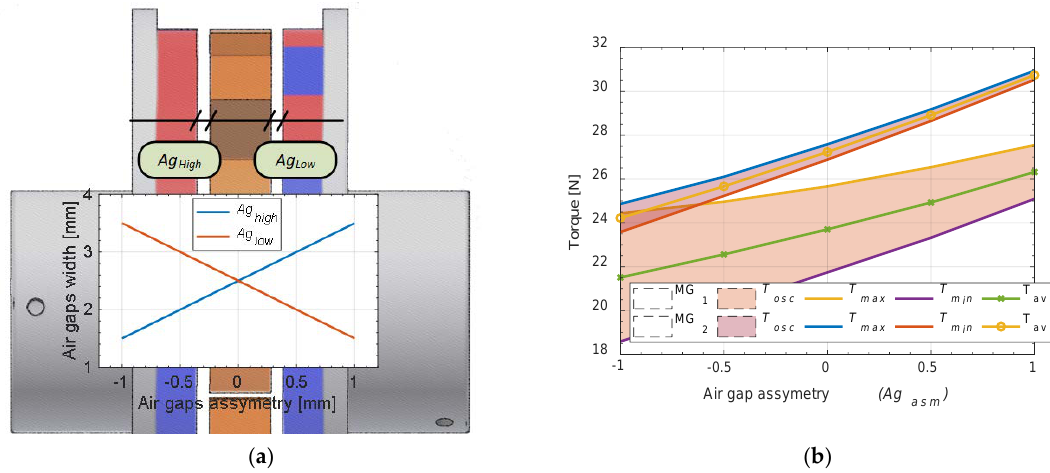
Figure 10. ( a ) The variants of the air gap asymmetry. ( b ) Calculated torque characteristics ( T min , T av , T max ) for AFMGs (MG 1 and MG 2 ) vs. air gap asymmetry ( Ag asm ).